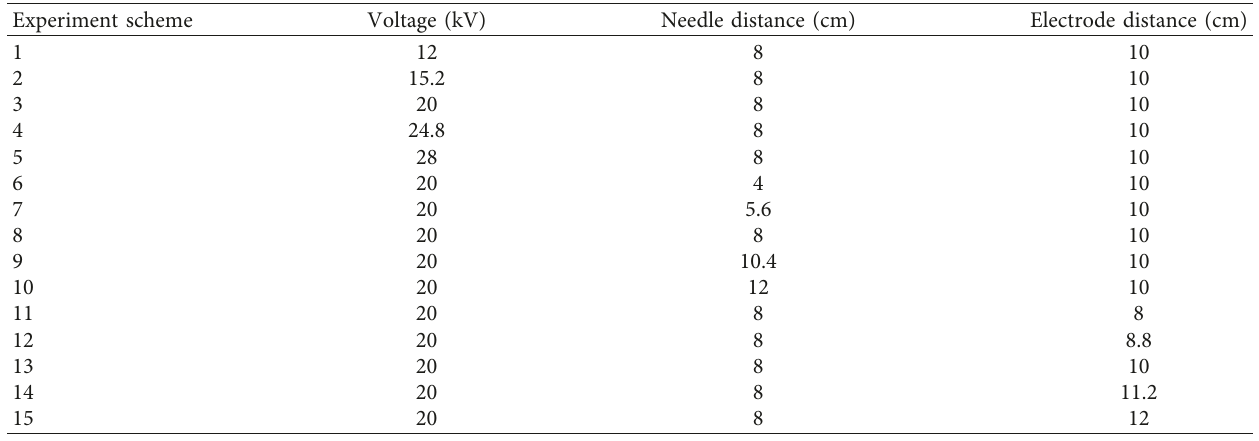
Table 3: The experiment design conditions using single electric parameter